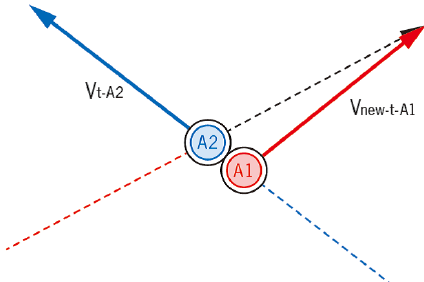
Fig. 15. AAs continue to move with new robots to the